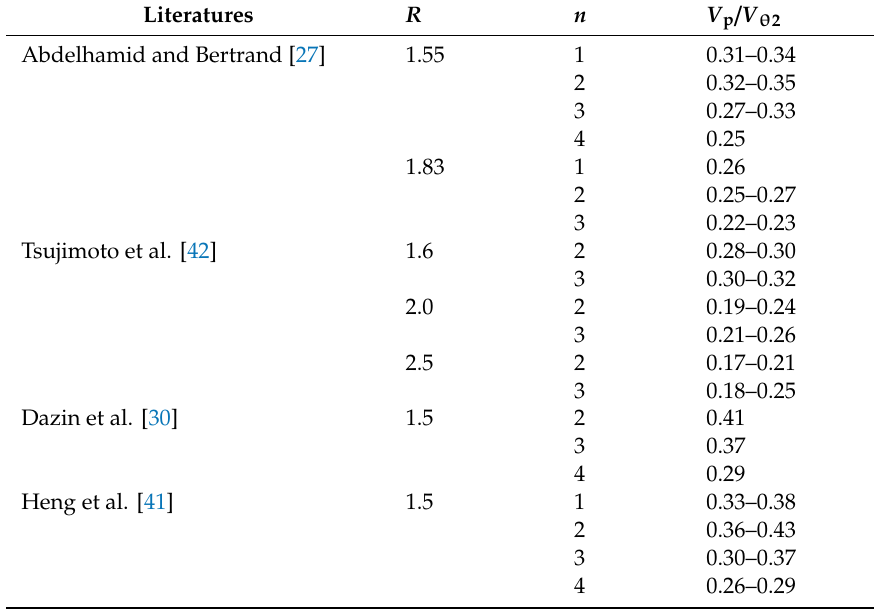
Table 2. Propagation velocity of rotating stall cells (extracted from available